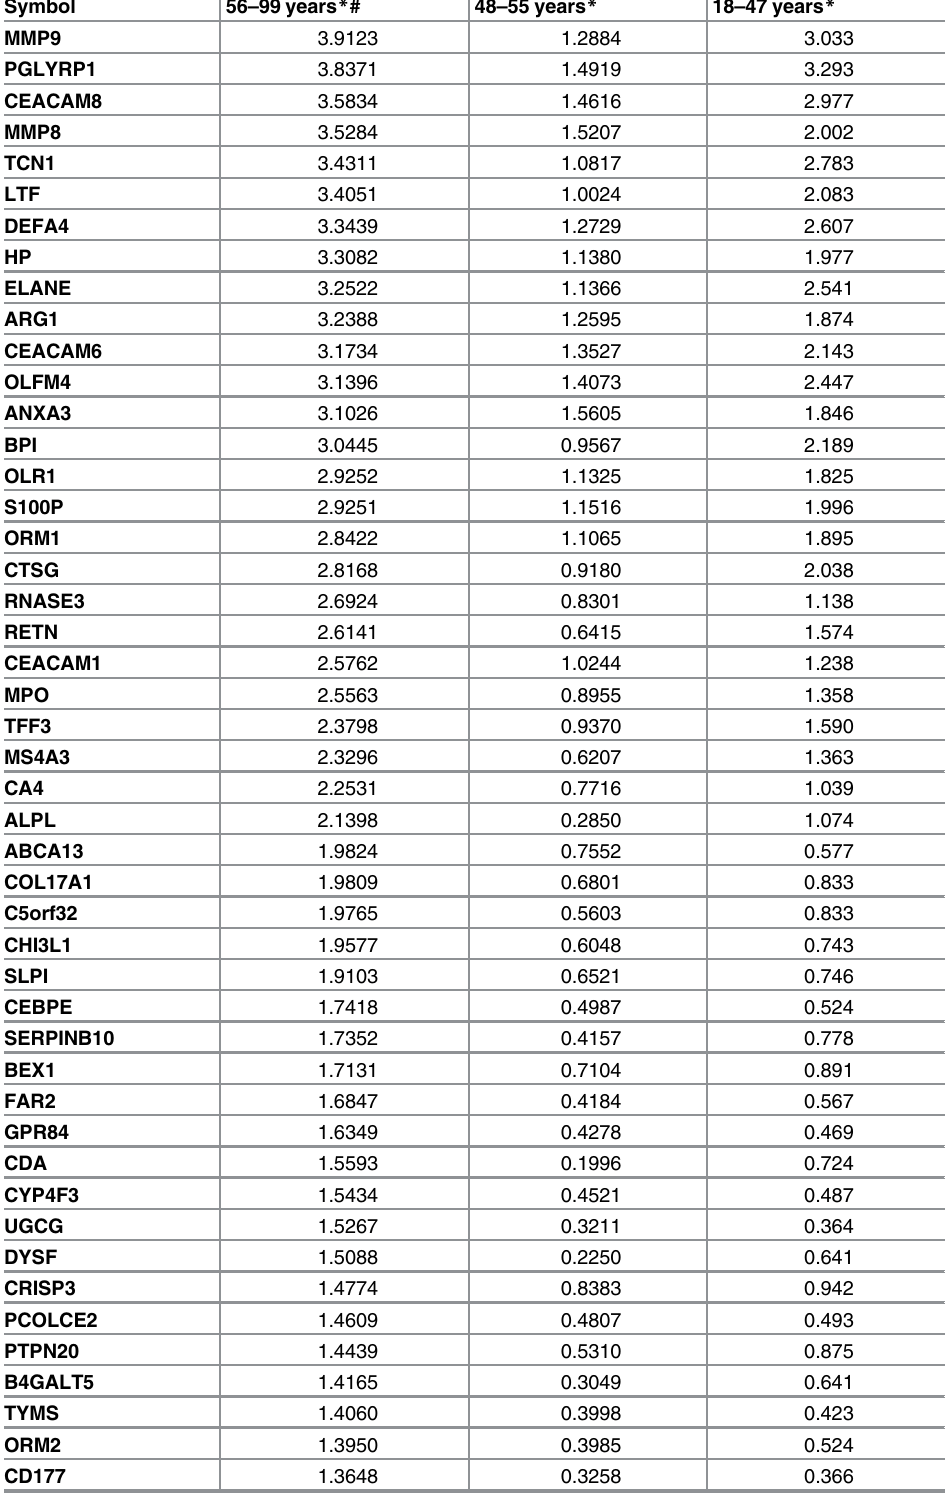
Table 3. Age-associated differences in the gene